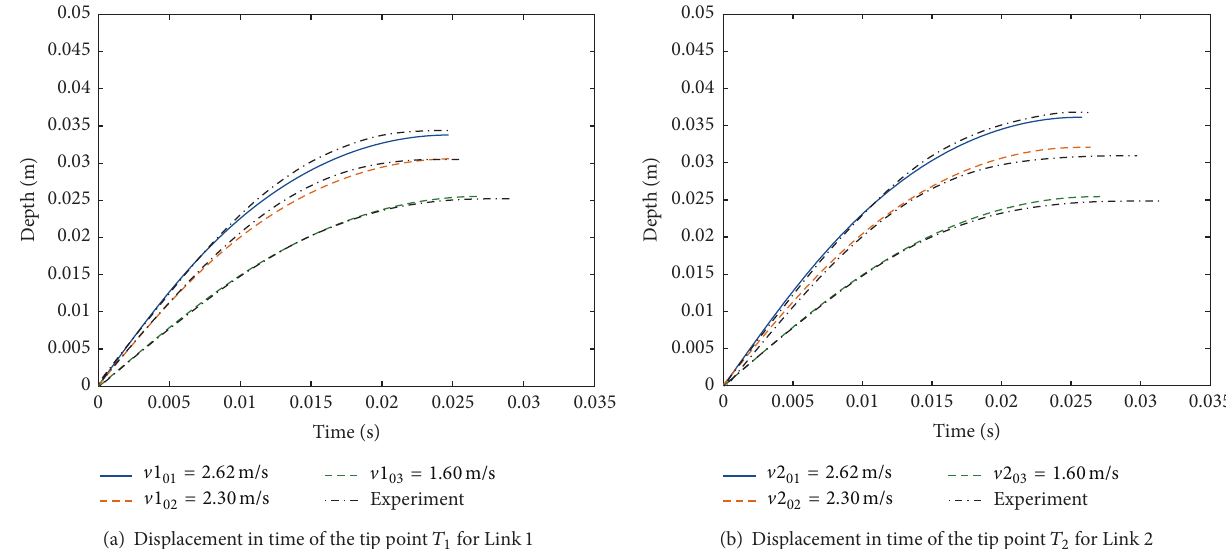
Figure 4: Simulation and experimental impact results for the penetration displacement of a double kinematic chain with two contact points: (a) for Link 1 and (b) for Link 2.